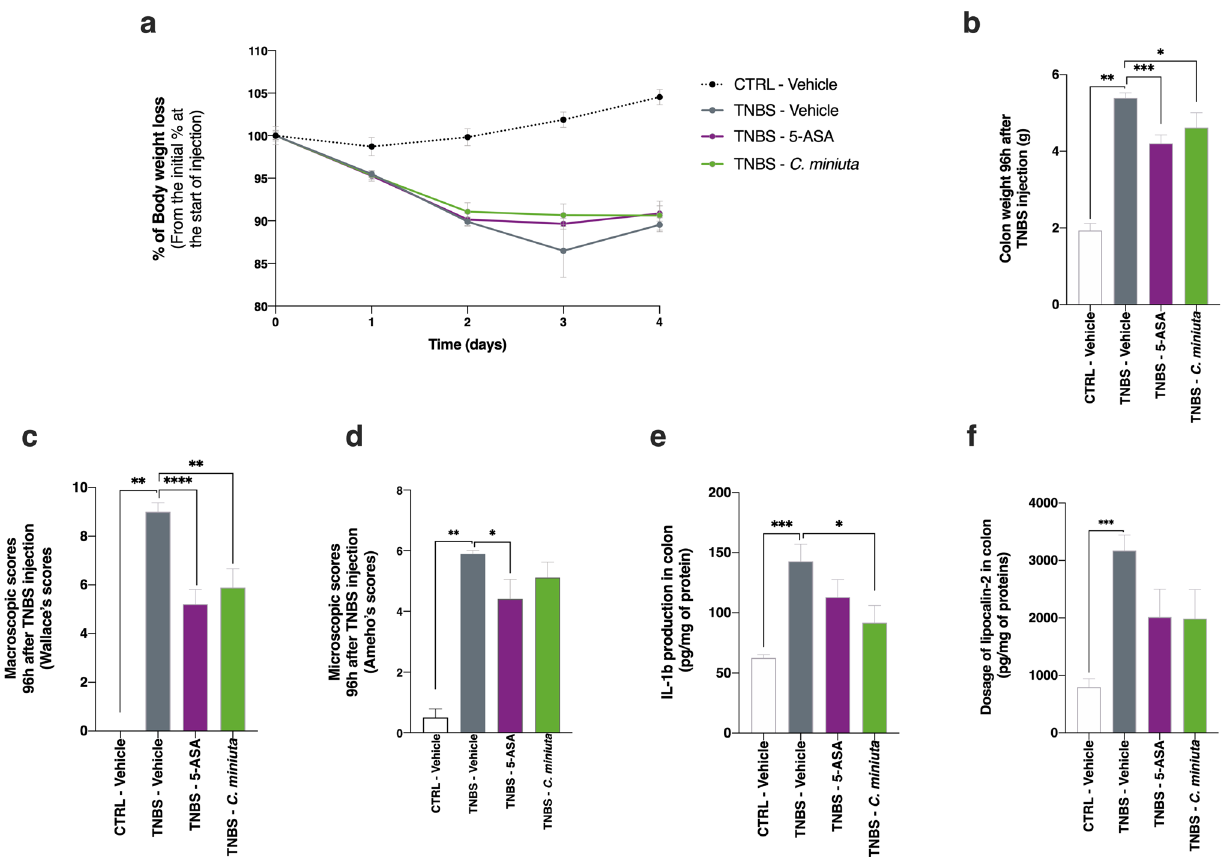
Figure 5. Effects of Christensenella minuta on TNBS-induced inflammation in rats. ( a ) Body mass over the course of the experiment; ( b ) colon mass at the end of the experiment; ( c ) colon microscopic scores; ( d ) colon macroscopic scores; colon IL-1β levels ( e ); and ( f ) levels of LCN-2, a proxy for colon neutrophil infiltration. Results of Mann Whitney U tests comparing the TNBS-Vehicle group to other three groups: *p < 0.05, **p < 0.01, ***p < 0.001, and ****p <